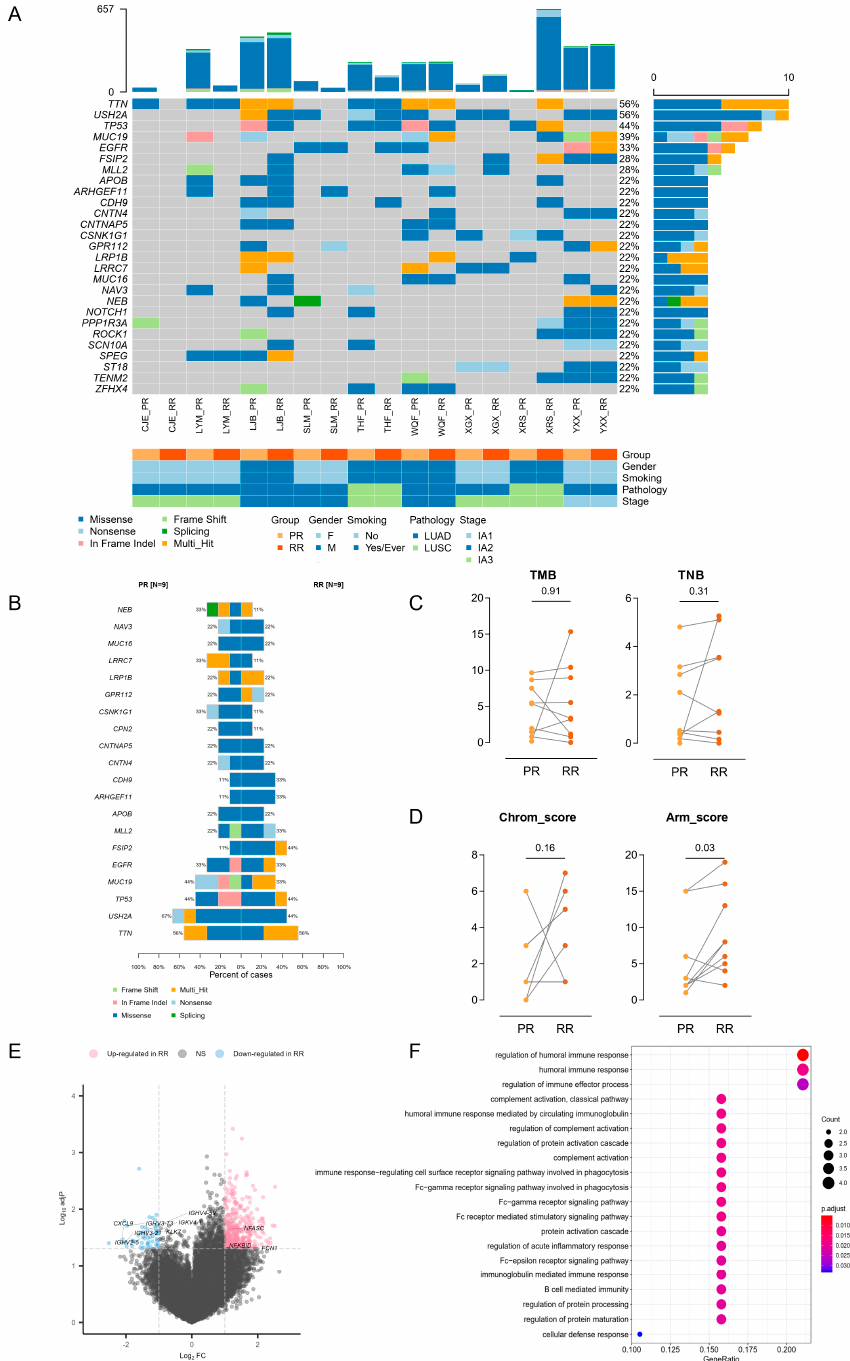
Figure 4. Genetic and transcriptional distinction between PR and RR. ( A ) Oncoplot depicting frequently mutated genes in paired PR and RR tumors. ( B ) Barplot comparing the prevalence of frequently mutated genes in PR and RR tumors. ( C ) Pair-wise comparison of TMB (left) and TNB (right) between PR and RR tumors. The difference was evaluated by Wilcoxon matched-pairs signed-rank test. ( D ) Pair-wise comparison of Chrom_score (left) and Arm_score (right) between PR and RR tumors. The difference was evaluated by Wilcoxon matched-pairs signed-rank test. ( E ) Volcano plot showing the upregulated (red) and downregulated genes (blue) in RR compared with PR. Vertical and horizontal dashed lines represent the cutoff for Log2FC (1 for upregulated and -1 for downregulated) and adjusted p -value (0.05). Genes related to immune effector process are annotated. ( F ) Dotplot showing that downregulated genes in RR versus PR enriched in immune-related Gene Ontology